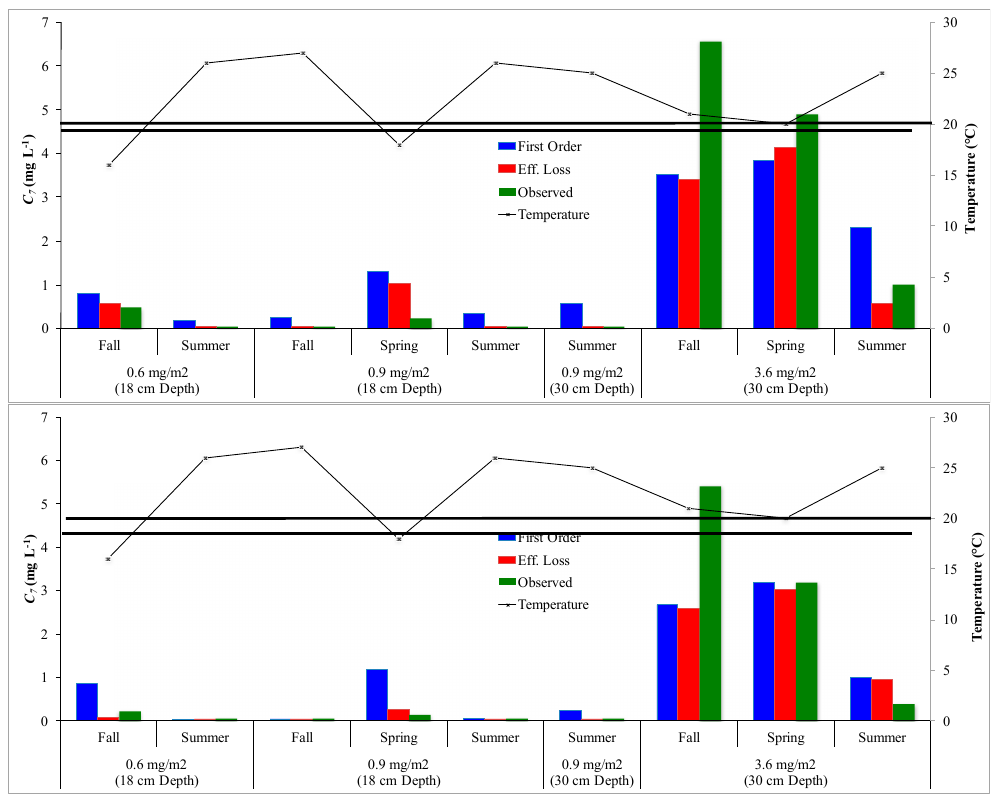
Figure 4. Predicted C 7 values (NO 3 -N concentrations after 7 days within the wetland mesocosm) for the first order decay model, efficiency loss model, and observed NO 3 -N concentrations in the WET-Org ( top ) and WET-Min ( bottom ) restored wetland systems during the 9 batch run experiments used for model validation. Black line designates an average water temperature of 20 °C.